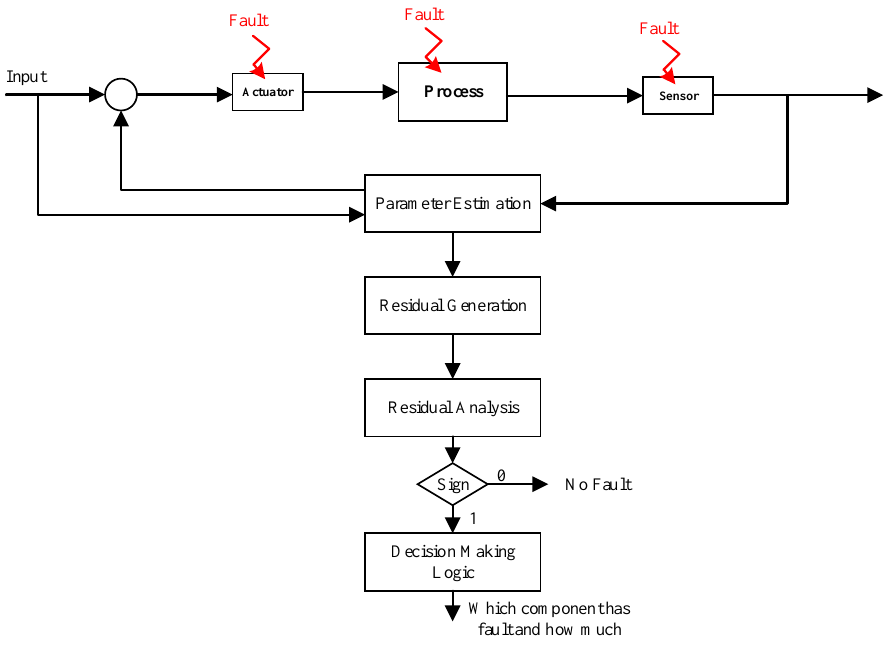
Figure 7. General structure of fault detection and isolation (FDI).